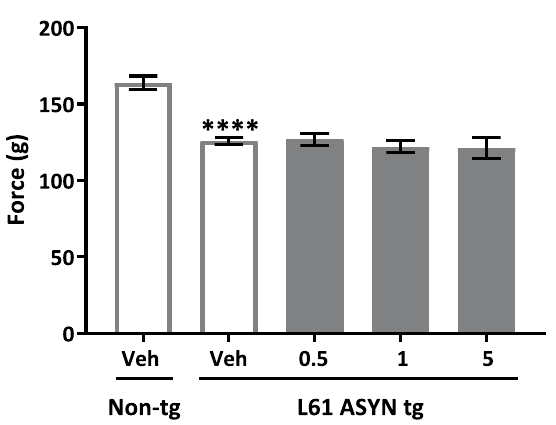
Figure 4. No effect of NPT200-11 treatment on Line 61 ASYN transgenic grip strength. There were statistically significant decreases in vehicle-treated Line 61 ASYN transgenic mouse grip strength ( **** p < 0.0001 vs. vehicle-treated non-transgenic control mice) , that were not improved by NPT200-11-treatment at any